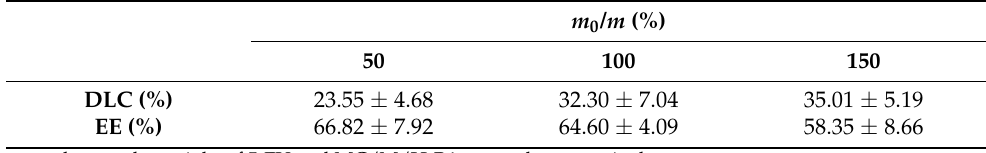
Table 3. The drug-loading content and entrapment efficiency of MC/M/H-B4 nanogels for 5-FU (all data are expressed as mean ± SD, n = 10).